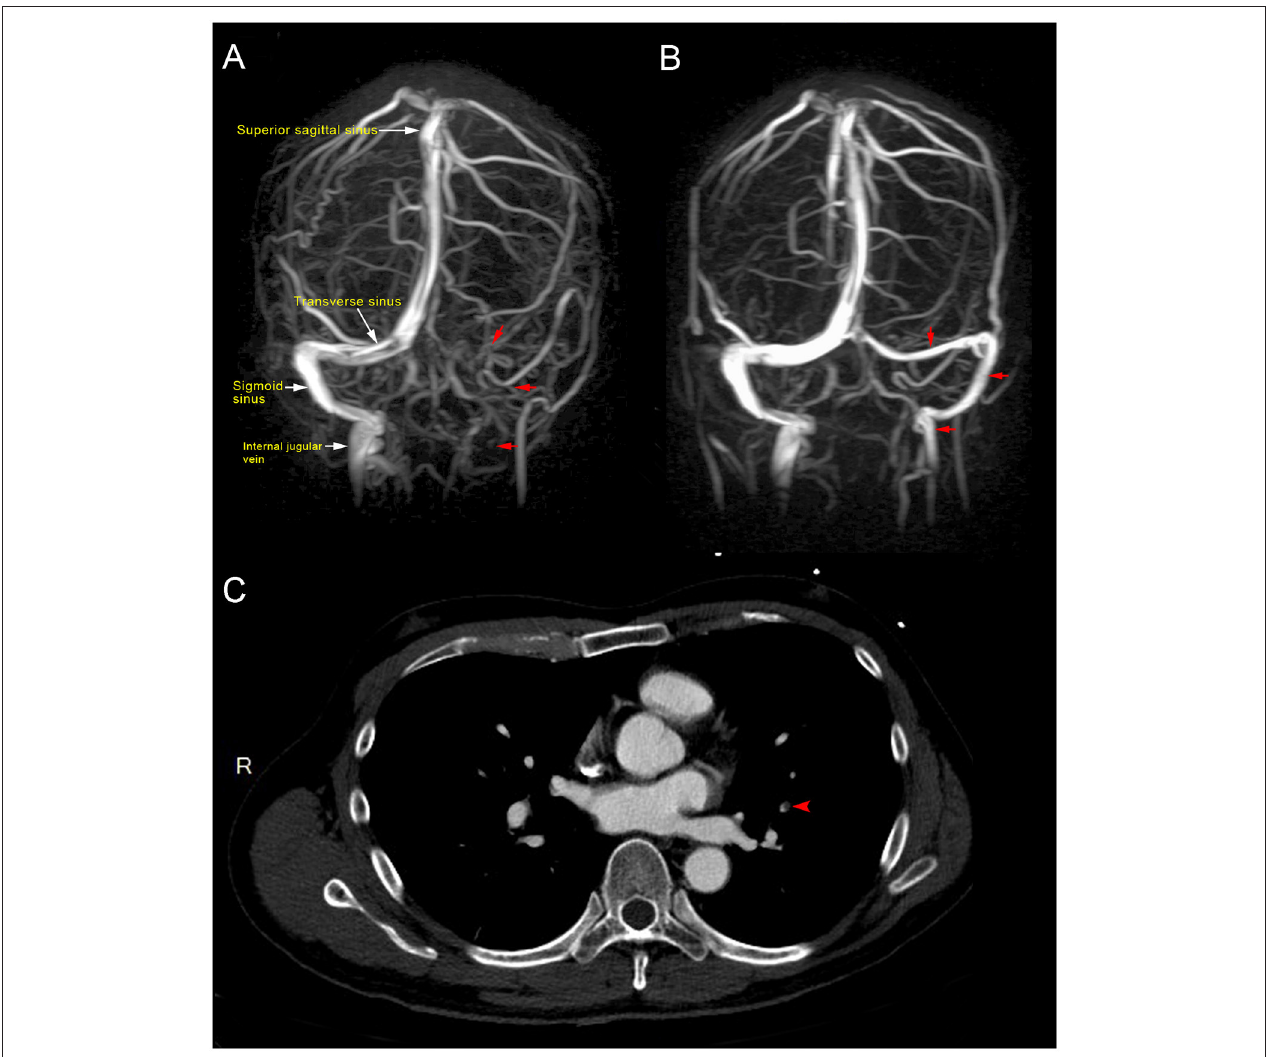
FIGURE 1 | (A) Magnetic resonance venography showed loss of signal in the left transverse sinus, sigmoid sinus, and left distal internal jugular vein (red arrow), which were consistent with dural venous sinus thrombosis at 10 days post-vaccination. (B) . Magnetic resonance venography after 2 months of direct oral anticoagulant (10mg apixaban twice daily for initial 7 days, 5mg twice daily for the following 2 months) showed patent left transverse sinus, sigmoid sinus, and left distal internal jugular vein (red arrow), indicative of recanalization and disease regression. (C) Computed tomography showed a filling defect in the left upper lung (red arrow), consistent with pulmonary